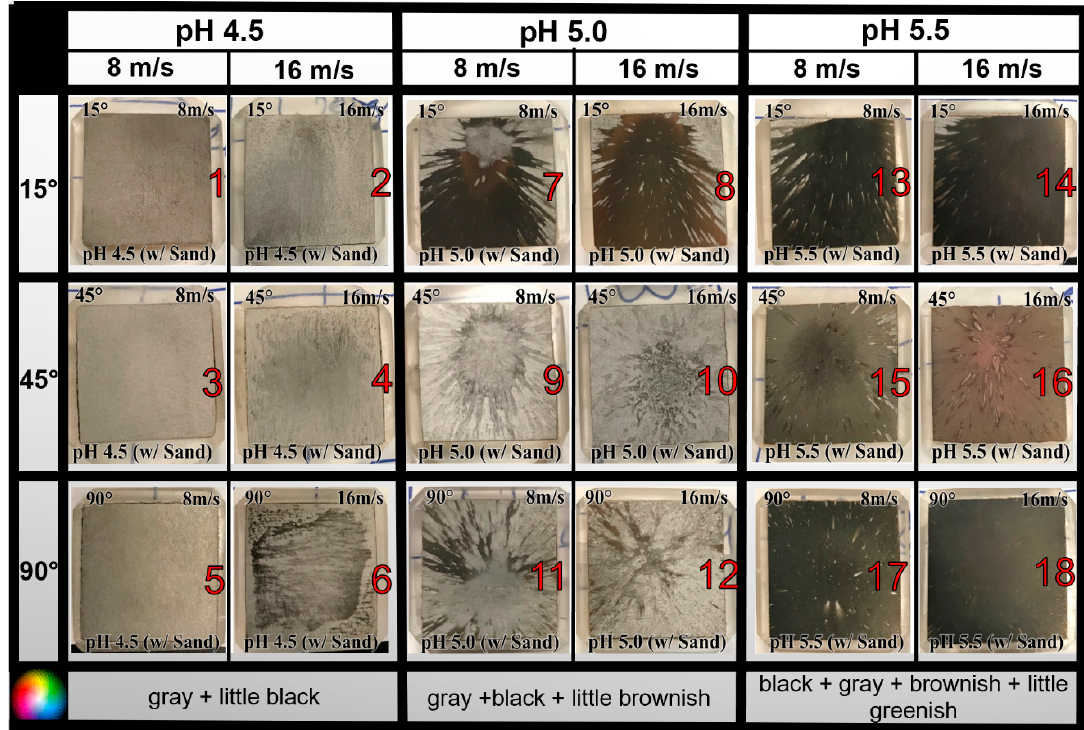
Figure 3. Pictures of API 5L X65 specimens after testing in CO 2 flow accelerated corrosion (FAC) at three pH levels (4.5, 5.0, 5.5), three angles (15°, 45°, 90°), two velocities (8, 16 m/s), and at room temperature.